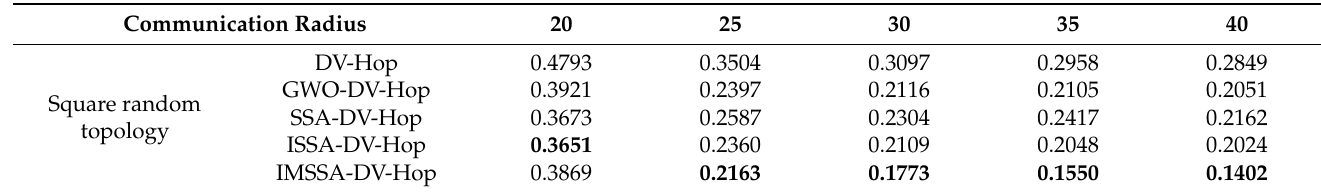
Figure 4. Localization error diagrams for different communication radius: ( a ) square random topology; ( b ) C-shaped random topology. Table 2. Localization error in different communication radius in square random topology.